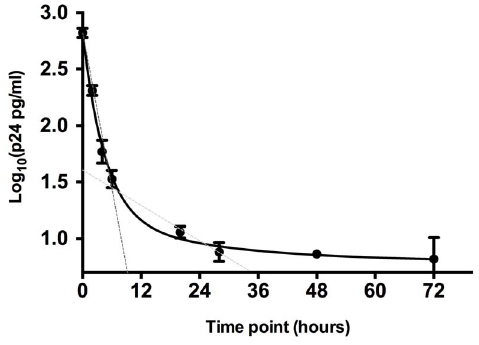
Figure 1. Astrocytes harbor short-term HIV-1 viral reservoirs. Virus half-life assays were performed using HIV-1 BaL and the immortalised human foetal astrocyte cell line, SVG. Cell-associated HIV-1 p24 was quantified via ELISA over a time course from 0 to 72 h. The curve of best fit is shown in black. The initial virus half-life of 1.2 h is shown via a dotted dark gray line and the slower rate of 9.5 h is shown via a dotted light gray line. Dot points and error bars denote the mean and standard deviation, respectively. Data is representative of three independent experiments.